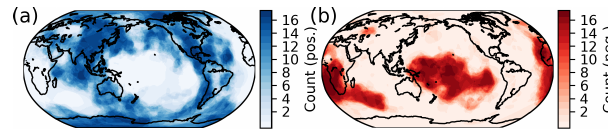
Figure 2. Vote maps at 2700km depth. (a) Vote map for fast (pos- itive) anomalies. (b) Vote map for slow (negative) anomalies. Note the clear signature of the two LLVPs underneath Africa and the cen- tral